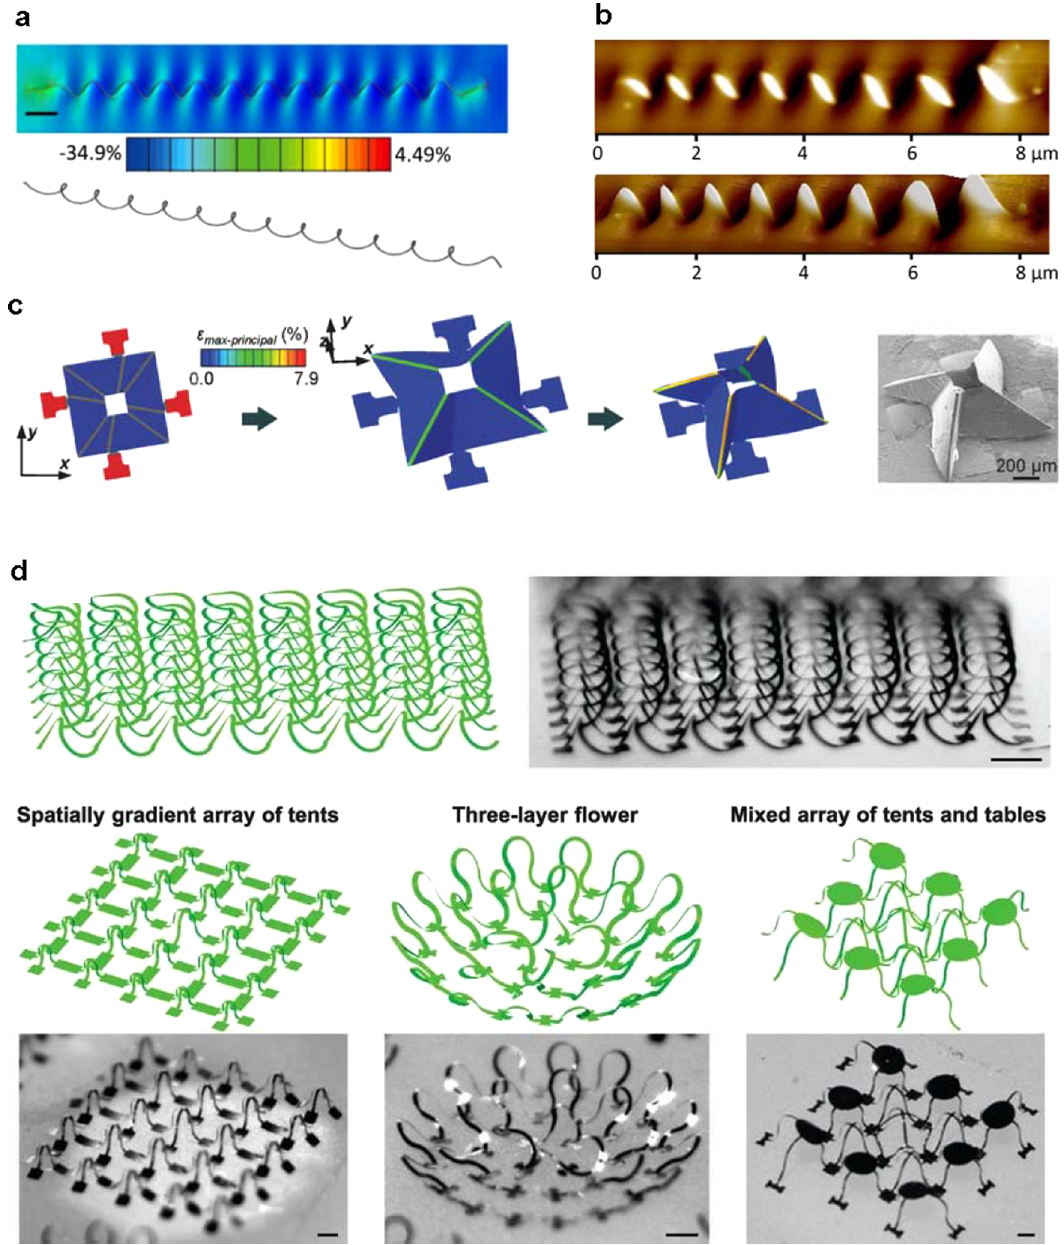
Fig. 7 a , b FEM simulations and experiment of the typical con fi gurations of the helical buckling of a SiNW on PDMS substrate (reprinted with permission from ref. 39); c complex “ windmill ” mesostructure (bilayer of silcon and SU8; reprinted with permission from ref. 40). d Distributed 3D mesoscale networks comprising interconnected collections of the 3D structures. (Reprinted with permission from ref.